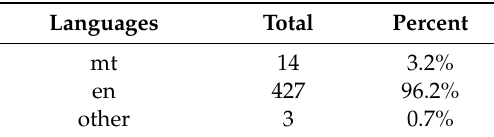
Table A37. Primary languages (mt).